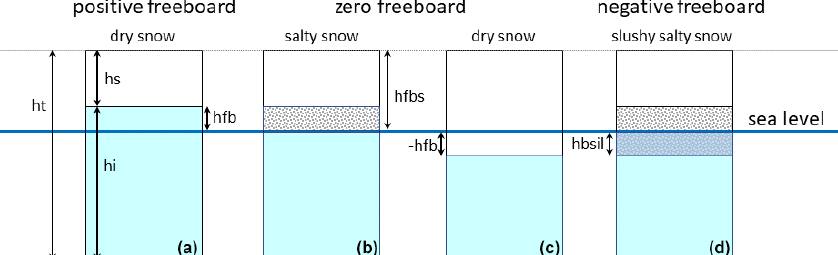
Figure 3. Some examples to show the concept of isostatic equilibrium of sea ice. In (a) , the ratio of snow depth (hs) to sea ice thickness (hi) is small, and sea ice freeboard (hfb) is positive. In (c) and (d) , the ratio of hs to hi is high, and hfb is negative. In (b) , while the sea ice freeboard (hfb) is zero, the lower part of the snow pack can be salty from brine wicking. This can also occur for positive ice freeboards. Panel (d) shows a slushy salty snow layer (hfbsil) due to surface flooding, whereas panel (c) has a dry, non-salty snow cover. The snow freeboard hfbs is the same in all four